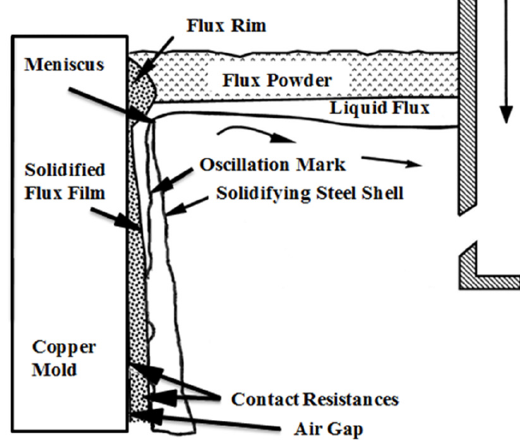
Figure 2. Position diagram of flux films in mold. Table 1. Parameters of mold flux films for peritectic steels.